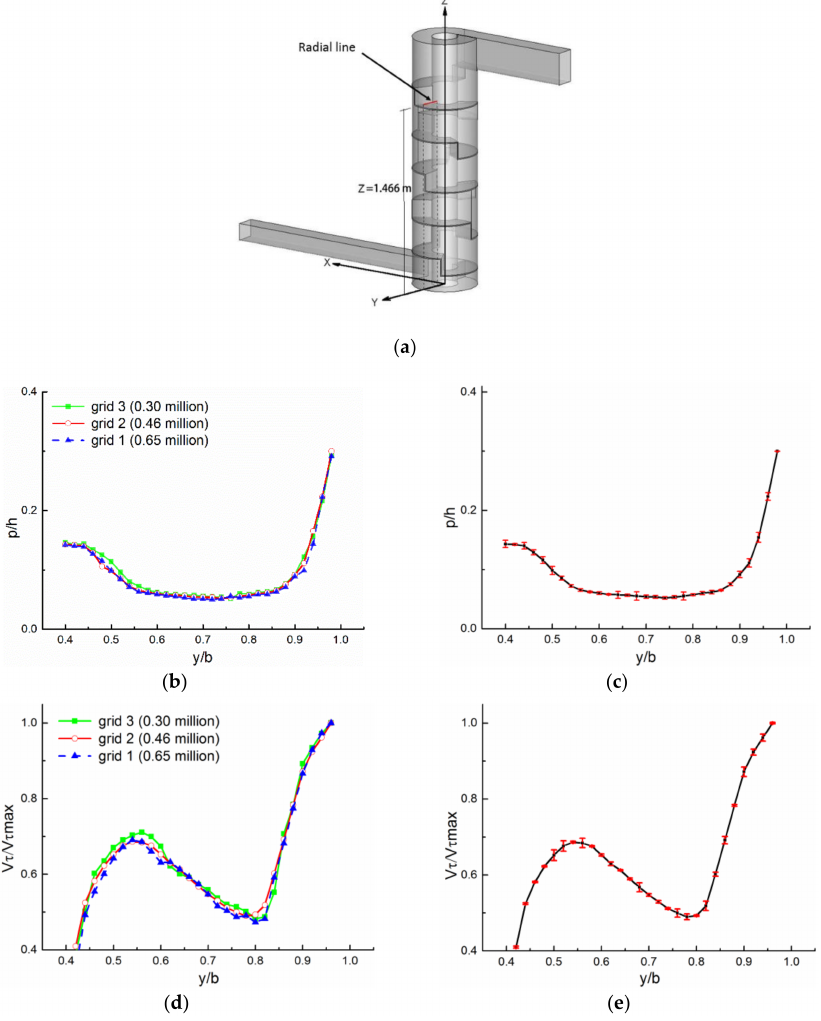
Figure 2. Grid convergence index value for different grid densities: ( a ) location of radial line; ( b ) pressure profile in models with different mesh numbers; ( c ) fine-grid solution, with discretization error bars computed using Equation (11); ( d ) tangential velocity profile in models with different mesh numbers; ( e ) fine-grid solution, with discretization error bars computed using Equation